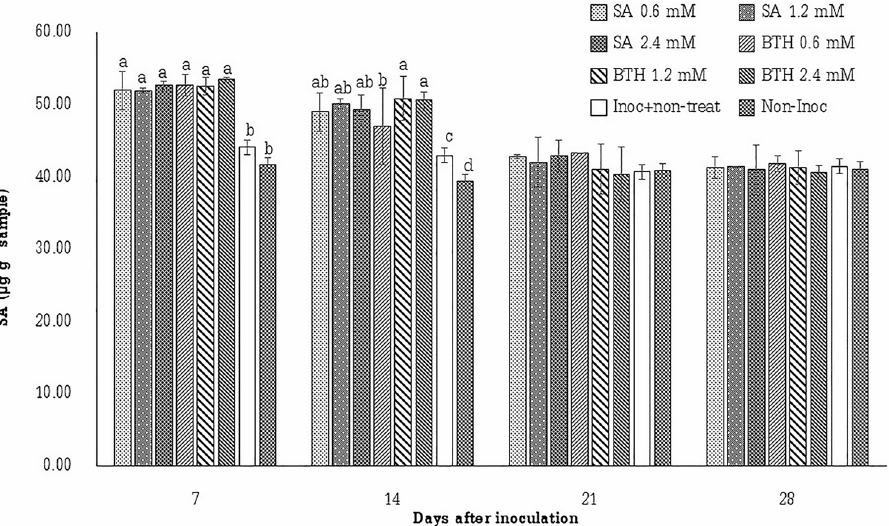
Figure 2. Quantification of salicylic acid (SA) in sugarcane leaves (µg g −1 sample) collected at 7, 14, 21, and 28 days after inoculation (n = 10 in each treatment).